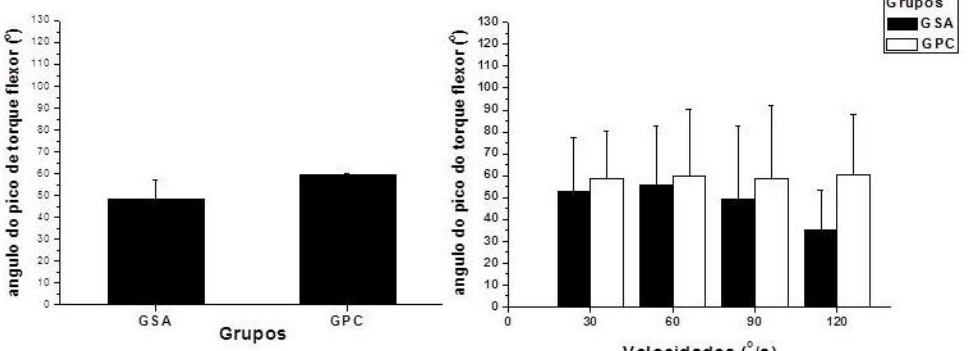
Figura 4. Média e desvio padrão do ângulo do pico de torque flexor de cotovelo nos grupos GSA e GPC e